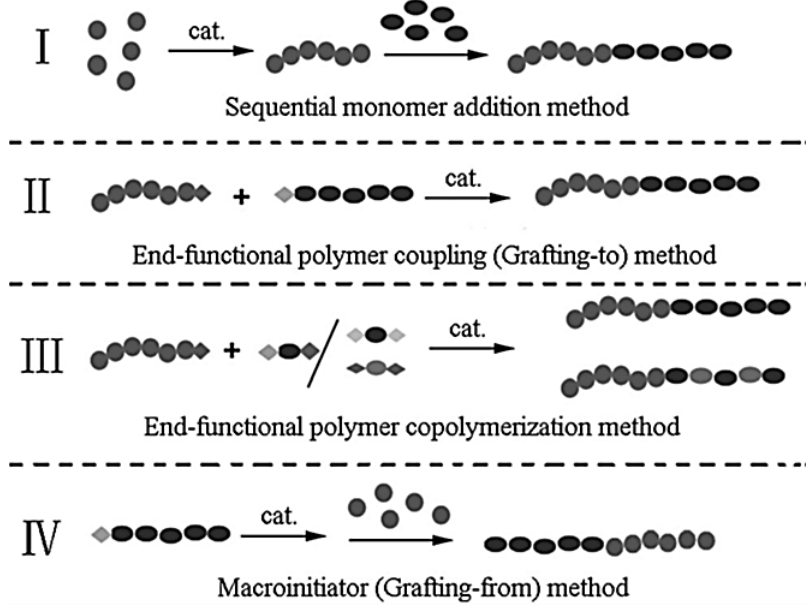
Figure 8. Synthetic approaches of all-conjugated D–A block copolymers. (The lighter shaded balls stand for p-type monomers or p-type polymers, and the darker one stands for n-type monomers or n-type polymers). Reproduced with permission [74].